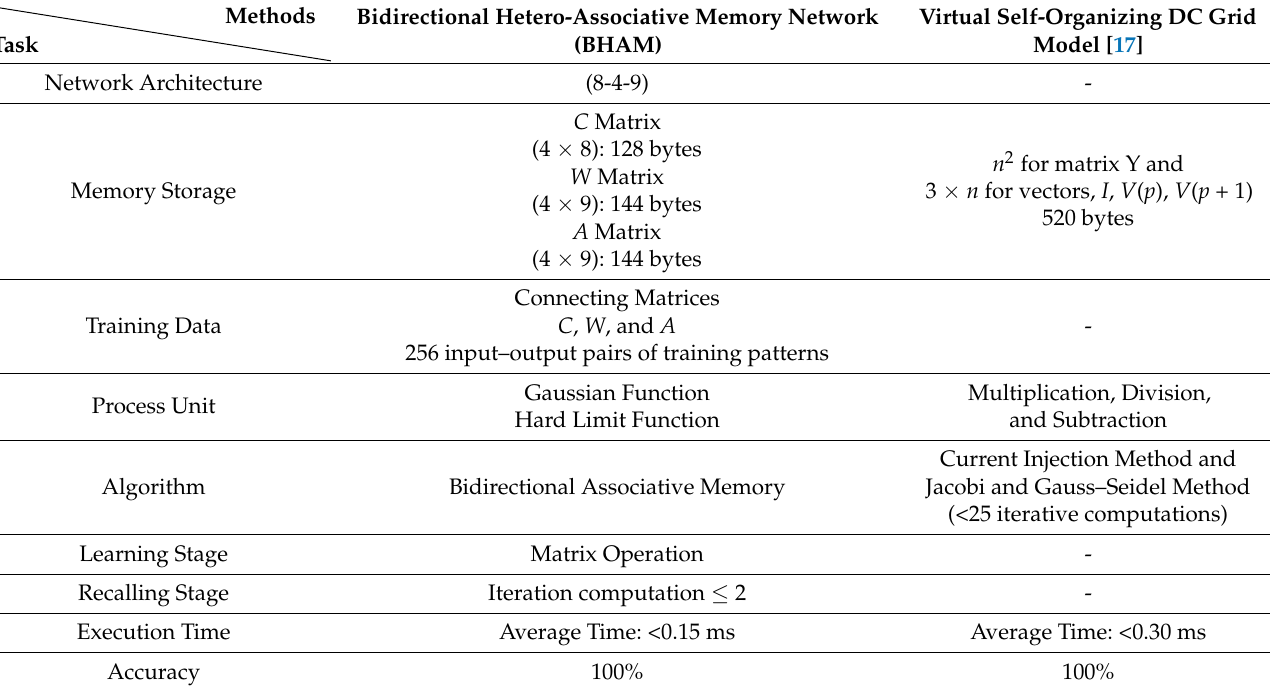
Table 2. Performance comparison of bidirectional hetero-associative memory network and virtual self-organizing direct current grid